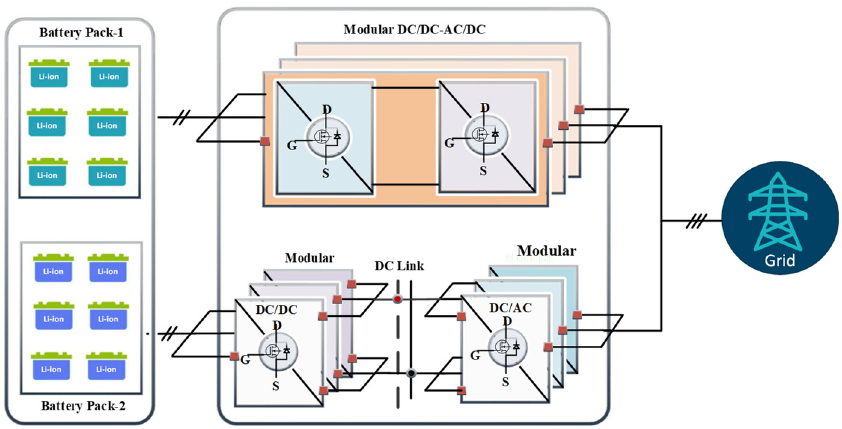
Figure 5. PE configuration 4: PCS-1 for battery pack-1 and PCS-2 for battery pack-2.